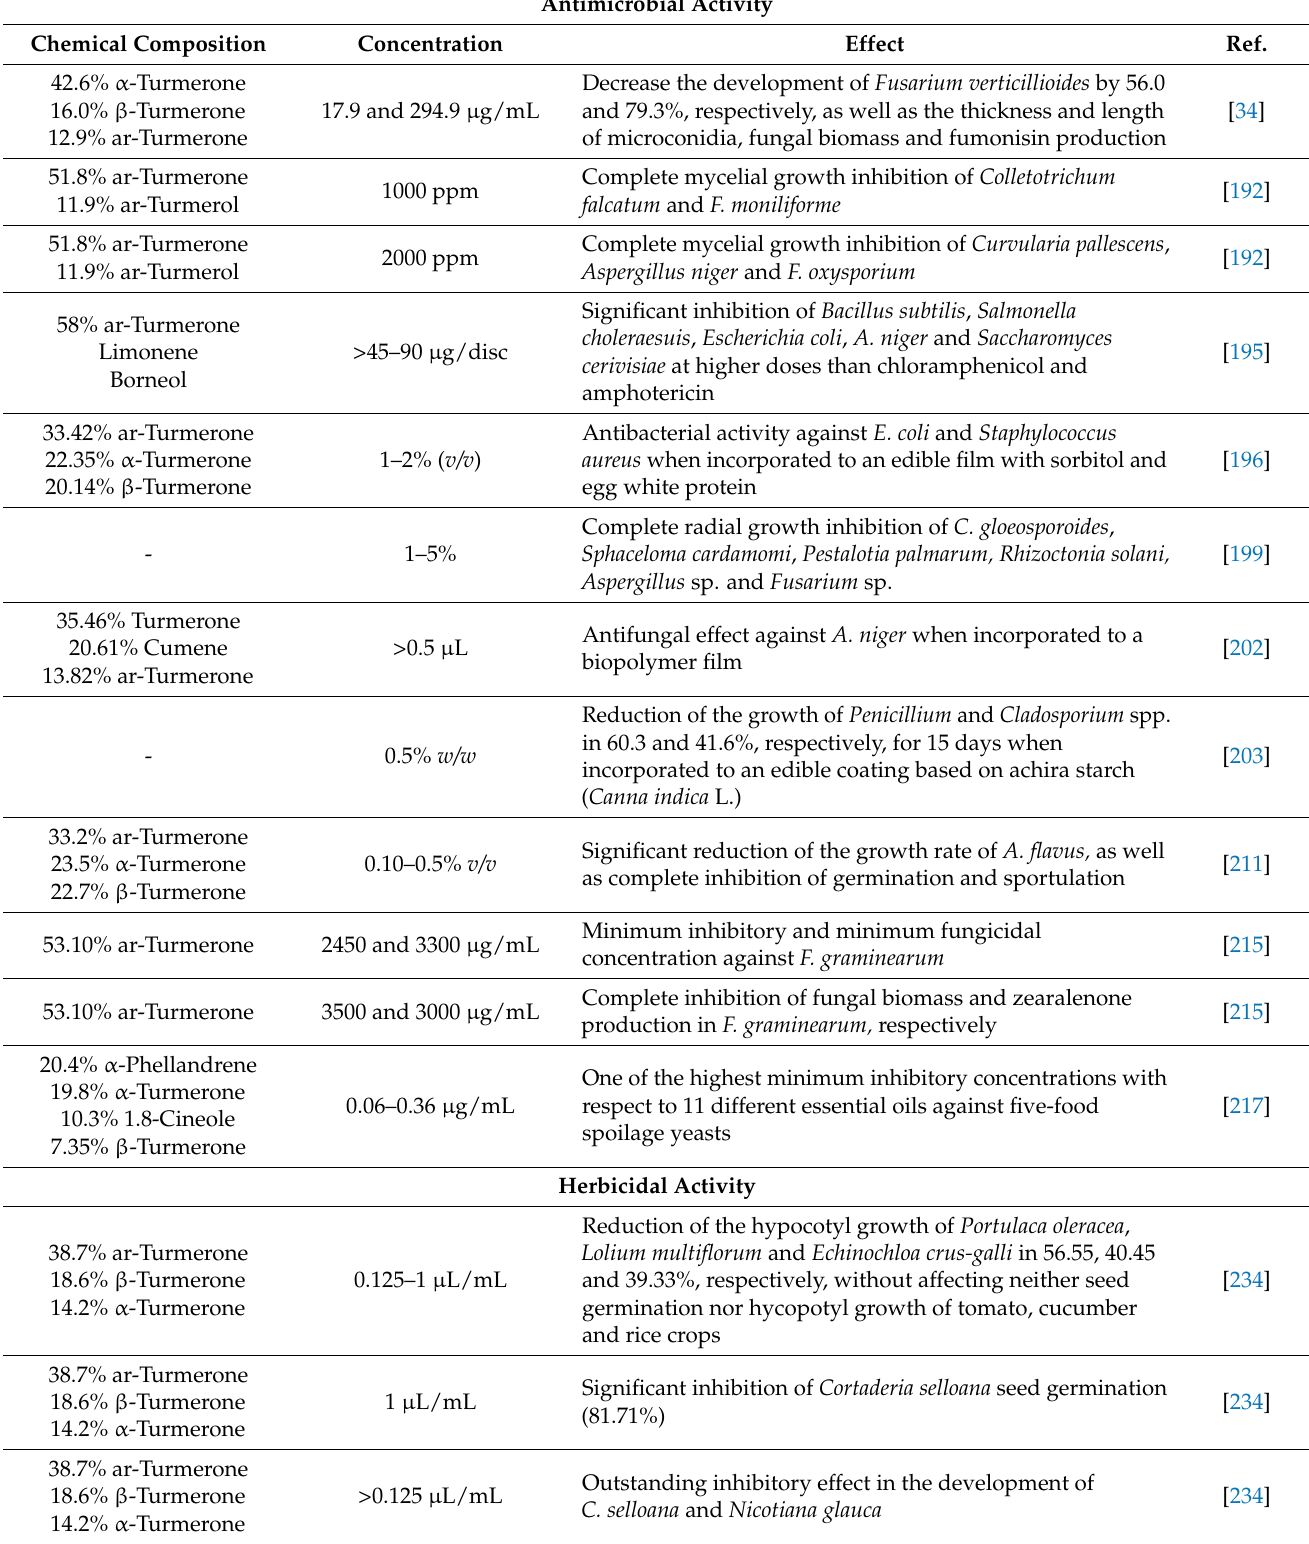
Table 3. Antimicrobial, herbicidal and antioxidant activities of C. longa essential oil in the agri-food industry. DPPH: 2,2- diphenyl-1-picrylhydrazyl, ABTS: 2,2 (cid:48) -azino-bis-3-ethylbenzothiazoline-6-sulphonic acid, BHA: butylated hydroxyanisole and BHT: butylated